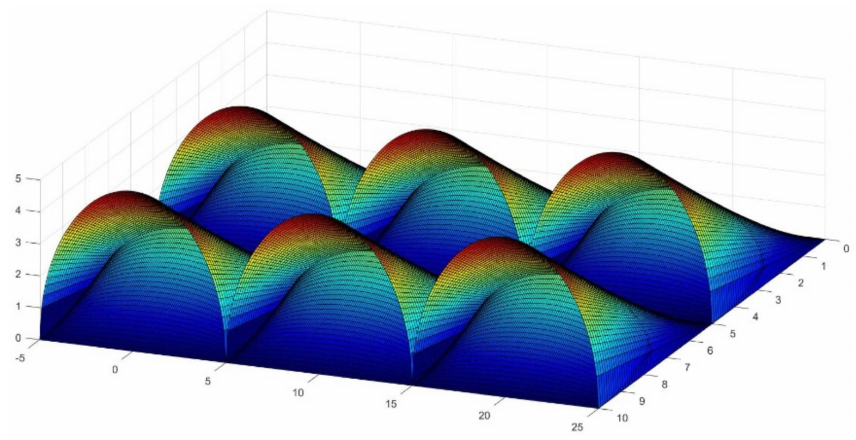
Figure 2. A suggested array of six conoidal skylights.